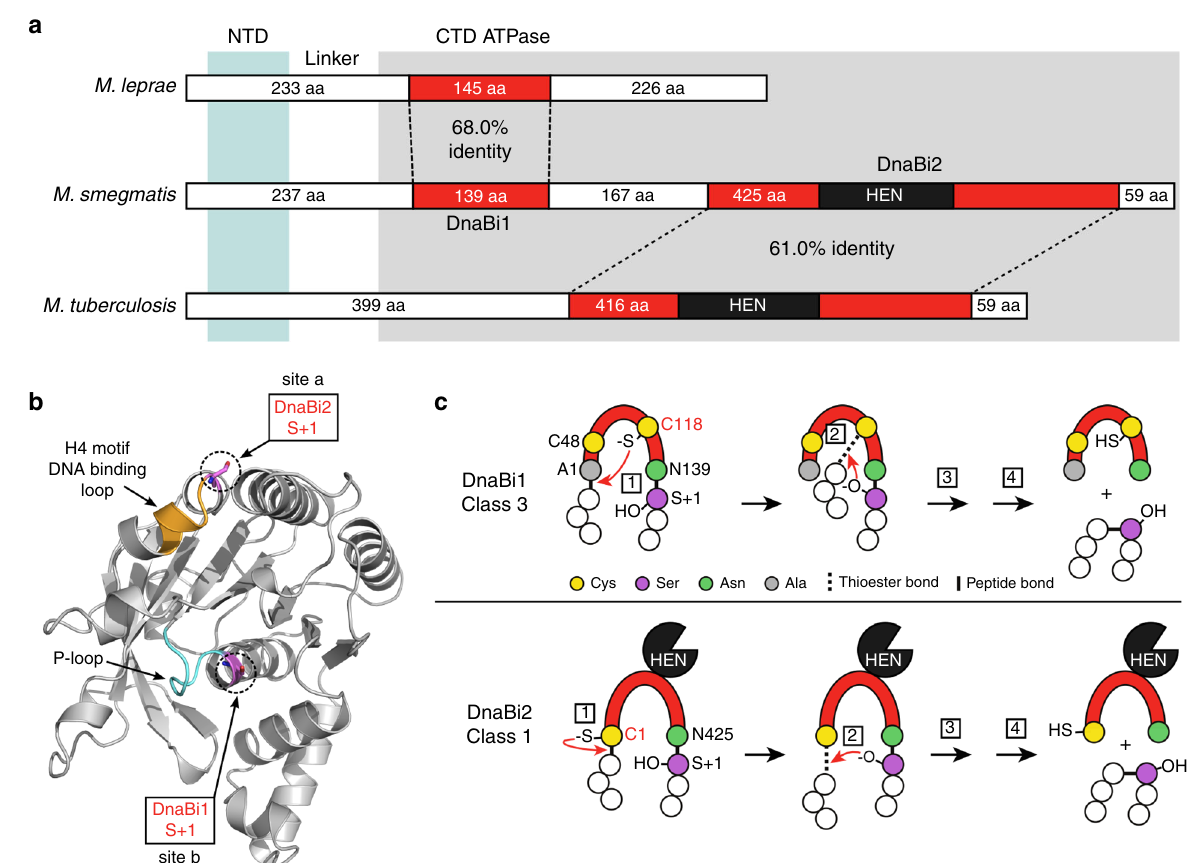
Fig. 1 Overview of mycobacterial DnaB inteins. a Relationship of DnaB inteins in three mycobacterial species. The two M. smegmatis ( Msm ) DnaB inteins (DnaBi1 and DnaBi2) were aligned to the single DnaB inteins in M. leprae ( Mle ) and M. tuberculosis ( Mtu ) using a protein pairwise alignment (EMBOSS Needle; http://www.ebi.ac.uk/Tools/psa/emboss_needle). The amino acid percent identity between inteins (red) are shown. The number of residues for the intein and extein fragments (white) are indicated and the homing endonuclease (HEN) is shown in black. The N-terminal domain of DnaB is indicated in light blue shading and the C-terminal ATPase is indicated in gray shading. NTD N-terminal domain, CTD C-terminal domain, aa amino acid. b Localization of DnaB intein insertions. A structure model of the DnaB ATPase domain (residues 200 – 461) is shown 54 . The insertion sites of DnaBi1 and DnaBi2 are indicated by the S + 1 in purple. The P-loop, where DnaBi1 is inserted, is cyan and the H4 motif/DNA-binding loop, where DnaBi2 is found, is orange. c Intein splicing mechanisms. The class 3 mechanism (top) is used by Msm DnaBi1 and Mle DnaBi, whereas the canonical class 1 pathway (bottom) is used by Msm DnaBi2 and Mtu DnaBi. See the main text and Supplementary Figure 1 for detailed splicing description and steps (boxed numbers).